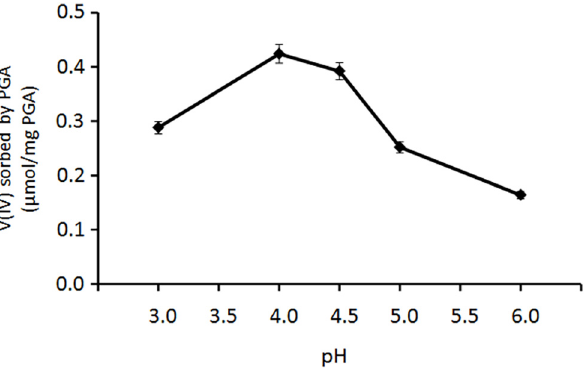
Fig 8. Sorption of V(IV) by 25 mg PGA at different pH values. Reaction volume 100 mL, V(IV) 120 μ M. Mean values ± standard